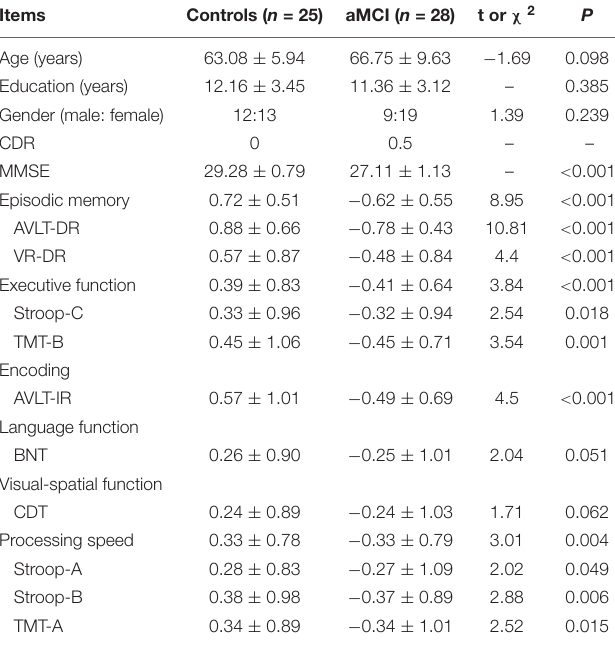
TABLE 1 | Demographic and neuropsychological